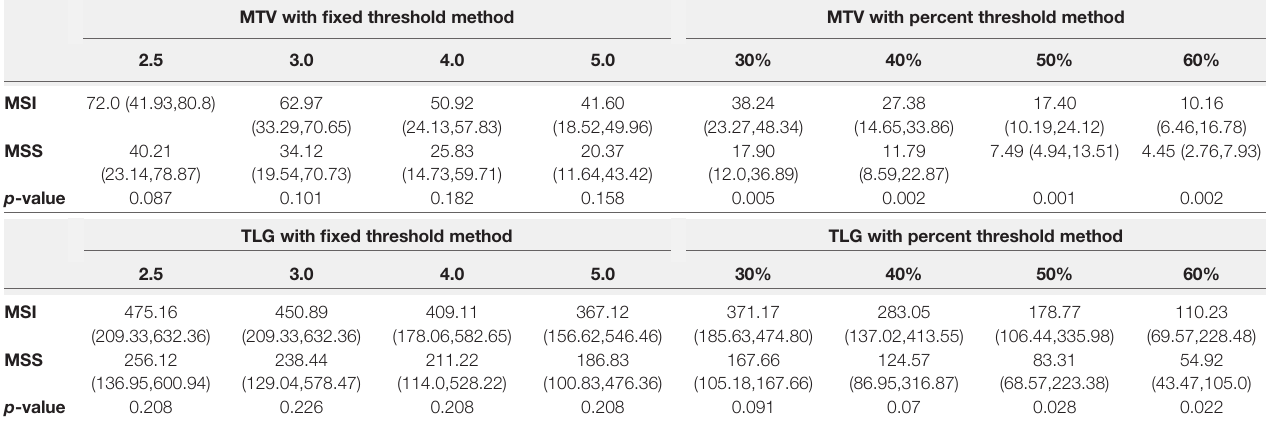
TABLE 3 | MTV and TLG measurements of CRC